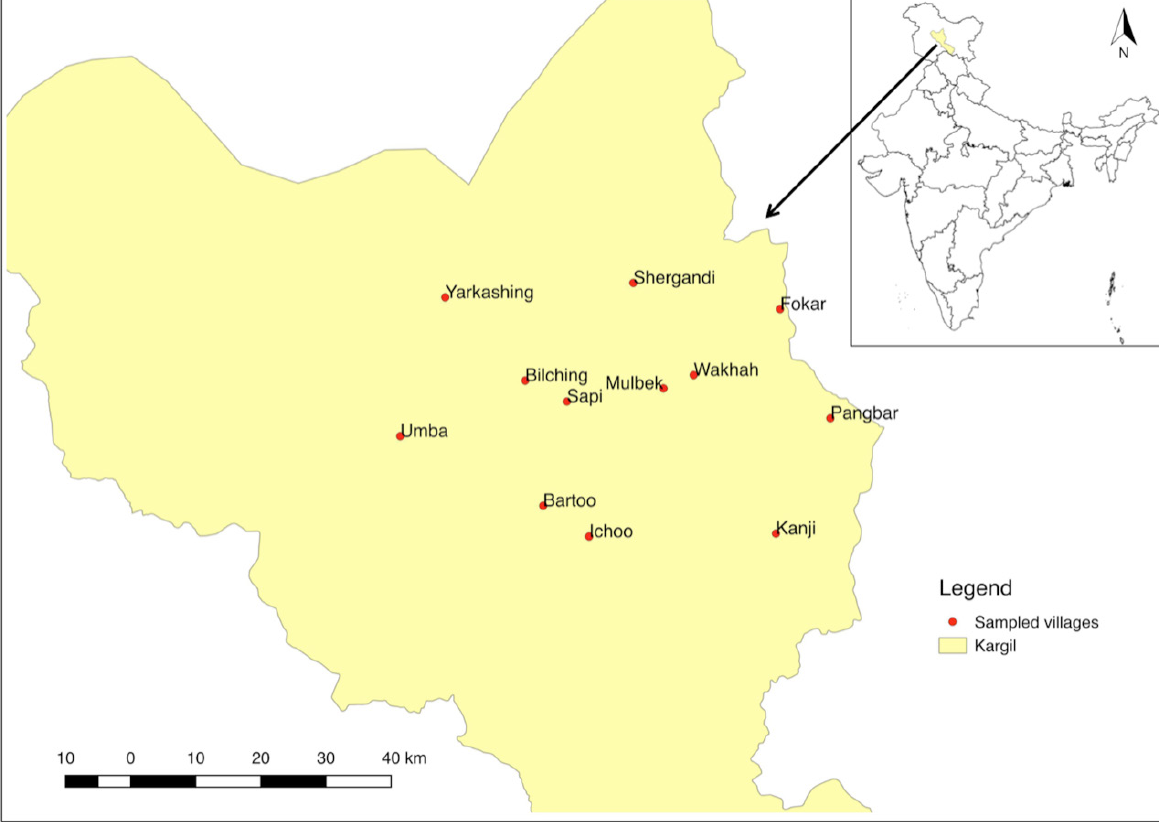
Figure 1. Study Area: location of the 12 sampled villages in Kargil, Ladakh,